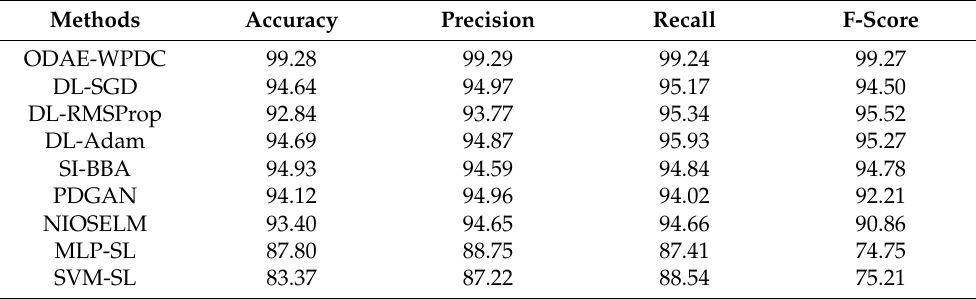
Table 3. Comparative analysis of ODAE-WPDC approach with recent algorithms.